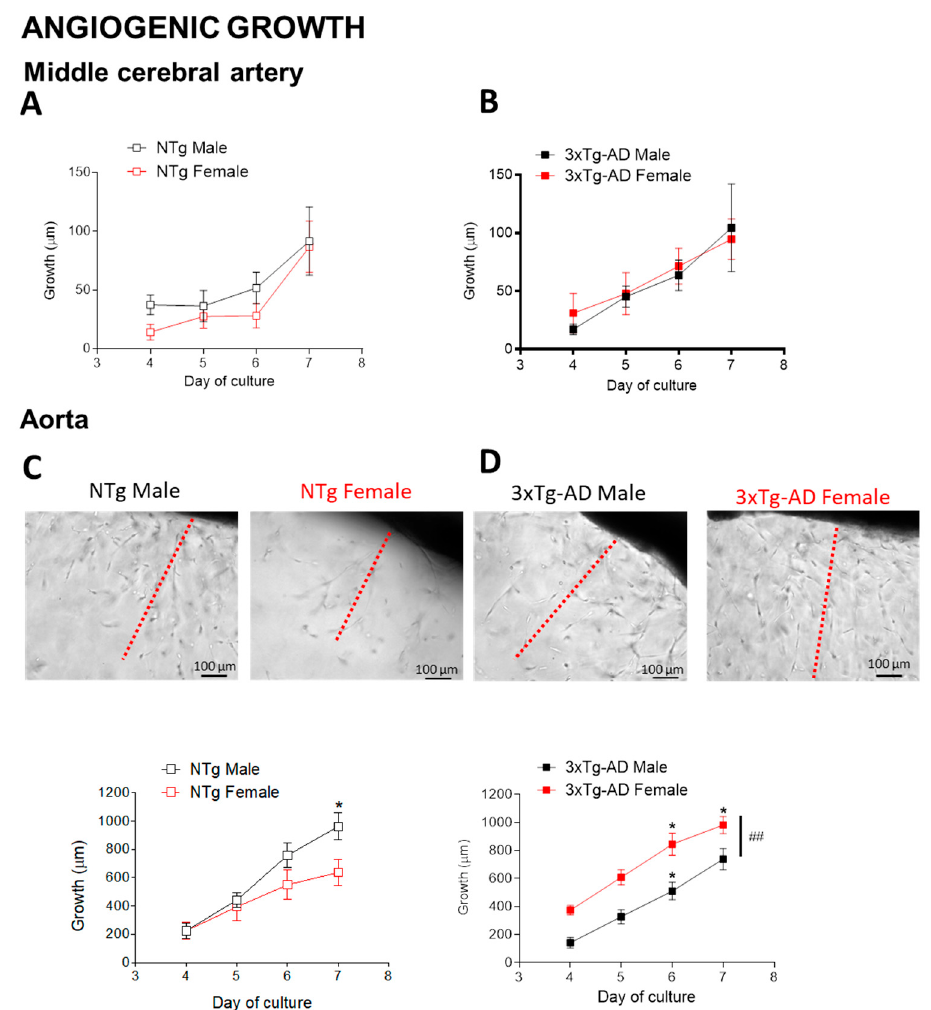
Figure 7. Influence of sex and genotype on the MCA and aortic angiogenic response. Analysis of neovessel growth progression in MCA from NTg (A) and 3xTg-AD (B) male and female mice. Representative images of neovessel sprouting (above) at day 7 (left) or 6 (right) and analysis of neovessel growth (below) in aorta from NTg (C) and 3xTg-AD (D) male and female mice. Red dotted lines represent the length of the longest vessel sprouting from the artery’s outer surface (starting point). Results are the mean ± SEM from NTg, male n = 6–7, female n = 4–5; 3xTg-AD, male n = 10, female n = 5. Data were analyzed by two-way repeated measures ANOVA with Tukey post-test. * p < 0.05, ## p < 0.01.